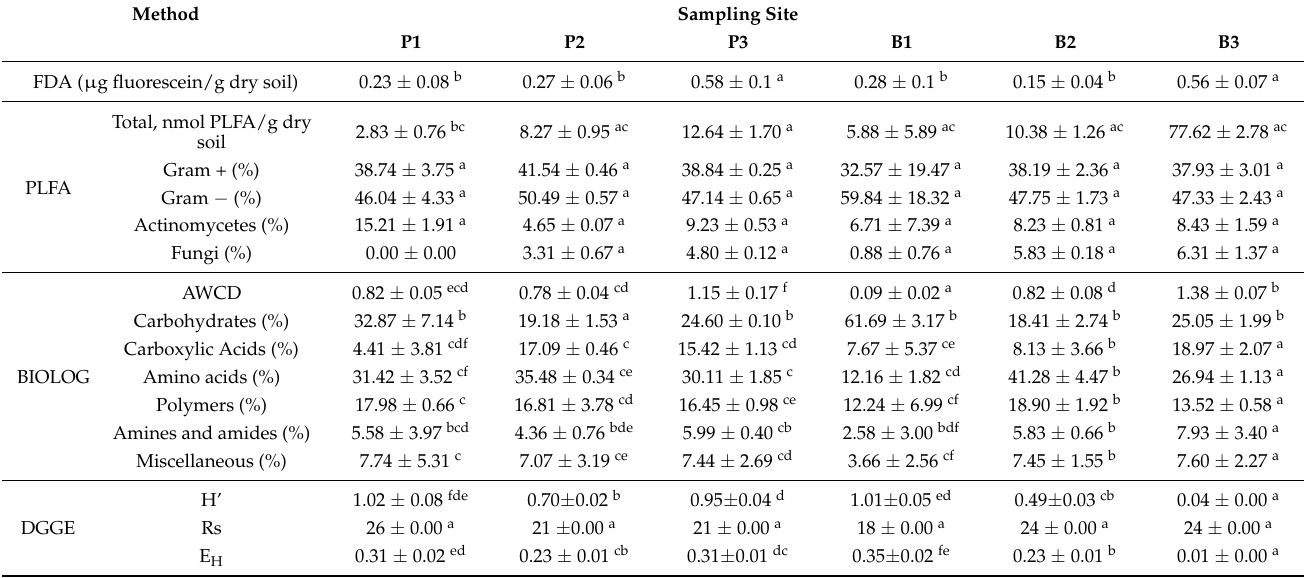
Table 3. Metabolic activity of microorganisms in soil